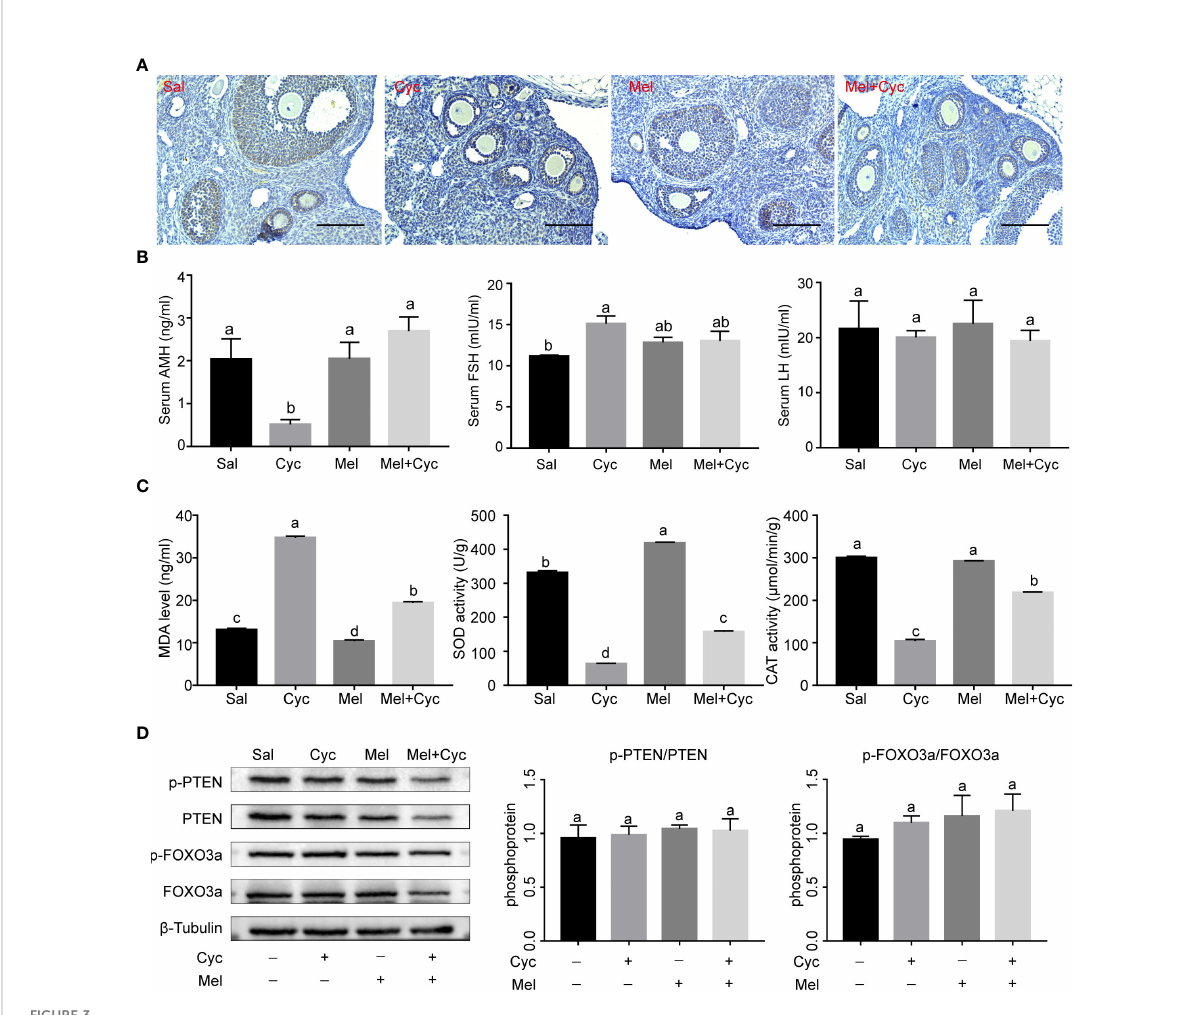
FIGURE 3 Effect of Mel on expression of AMH and oxidative stress in ovaries of six-week-old female mice 14 days after Cyc chemotherapy (Day 18). (A) AMH was expressed in granulosa cells of secondary and early antral follicles in Sal, Cyc, Mel, and Mel + Cyc groups (n = 6). Bar = 200 m m. (B) Cyc combined with Mel therapy prevented the decrease of serum AMH and LH levels but there was no signi fi cant change in serum FSH levels (n = 6). (C) Biochemical analysis of the ovarian CAT, SOD activities, and MDA levels (n = 6). (D) Phosphorylation levels of PTEN and FOXO3a did not change signi fi cantly after treatment with Cyc and Mel (n = 6). a,b Values with different letters are signi fi cantly different from each